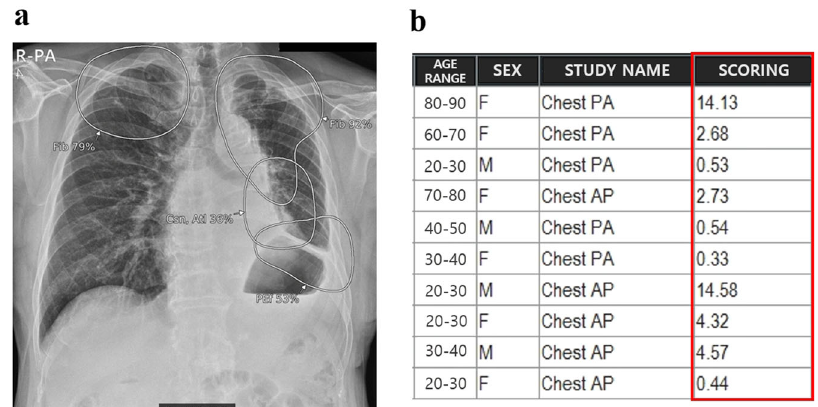
Fig. 3 Integration of AI for CXRs on PACS. a The AI result attached to the second image of the original CXR contains a contour map, abbreviations, and the abnormality score of detected lesions. Doctors can simply refer to the AI results by scrolling down the original image on the PACS. b The highest abnormality score is used as the total abnormality score of each CXR, and this was listed as a separate column (red square) on the